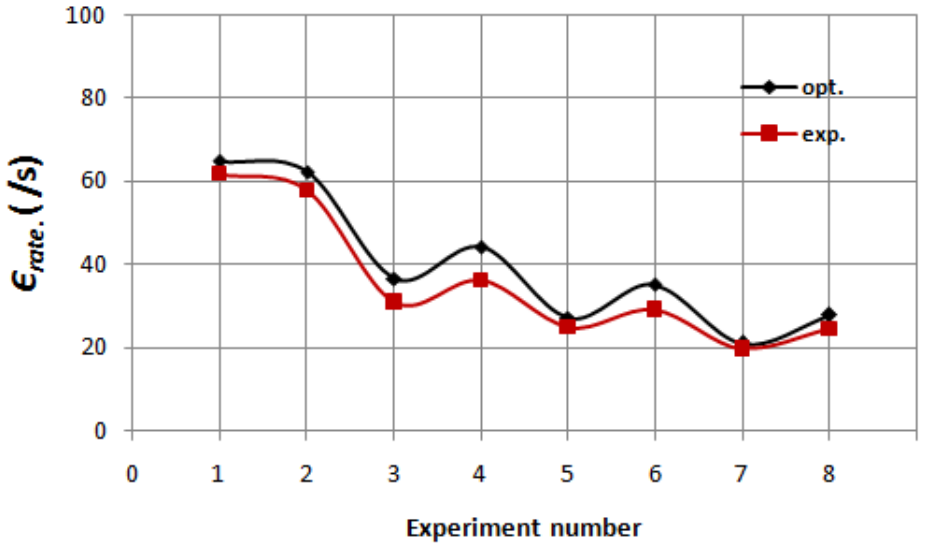
Figure 23. Comparison of DE optimal and experimental values for effective strain rate.